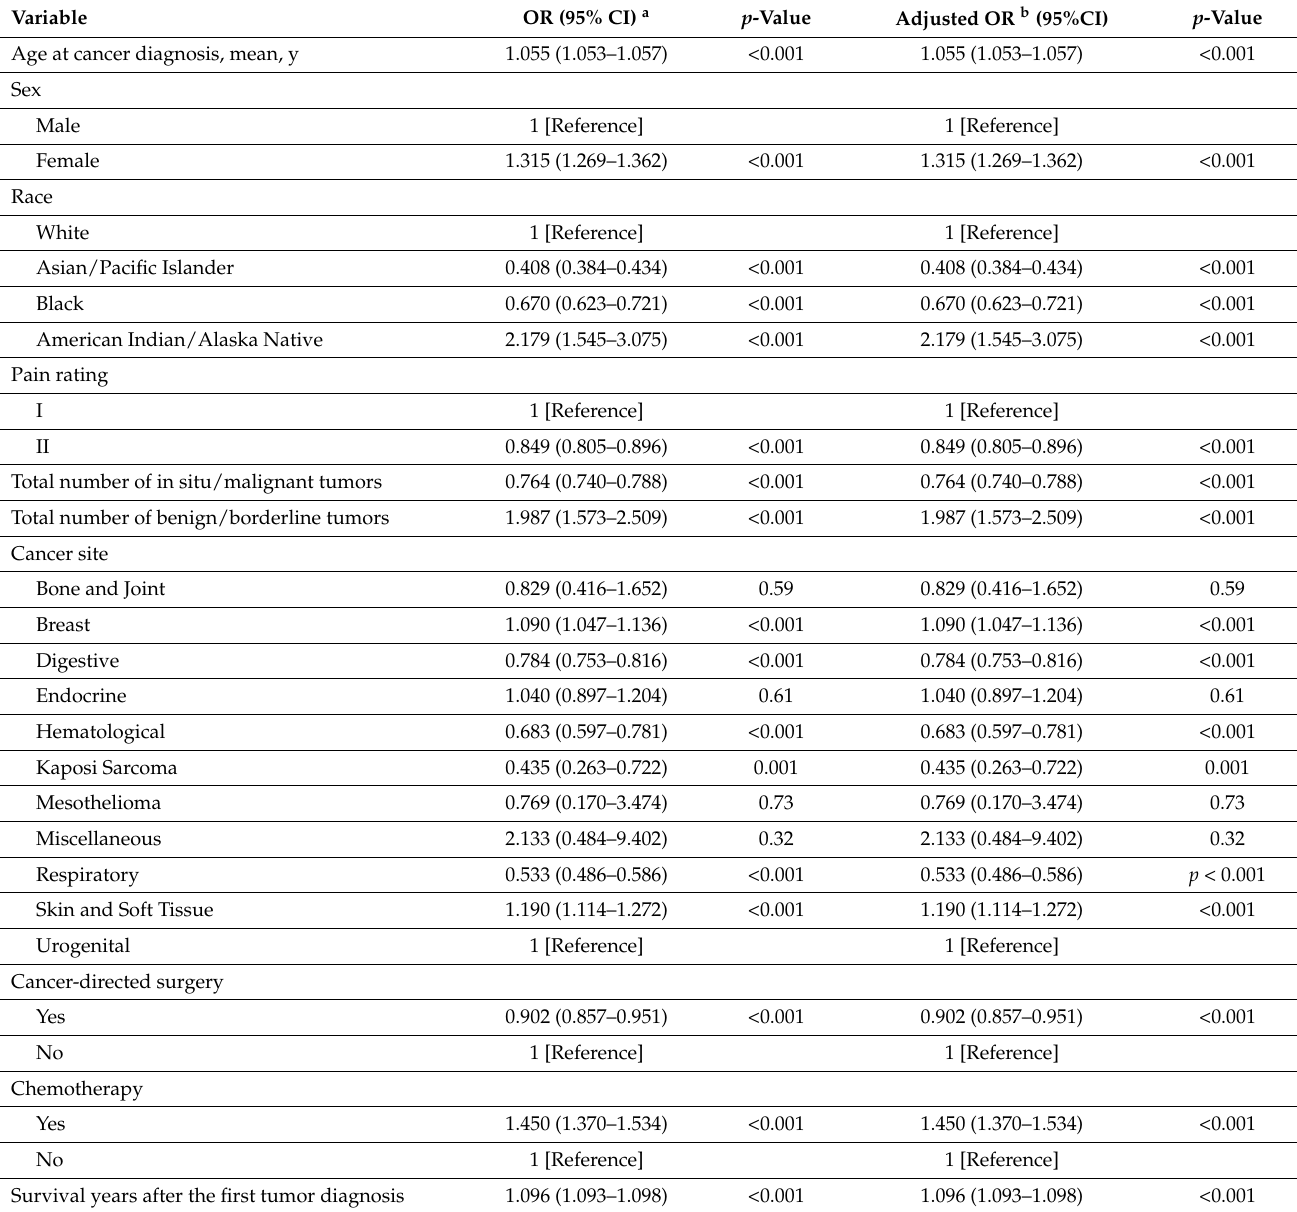
Table 2. Analyses of risk factors for AD in cancer